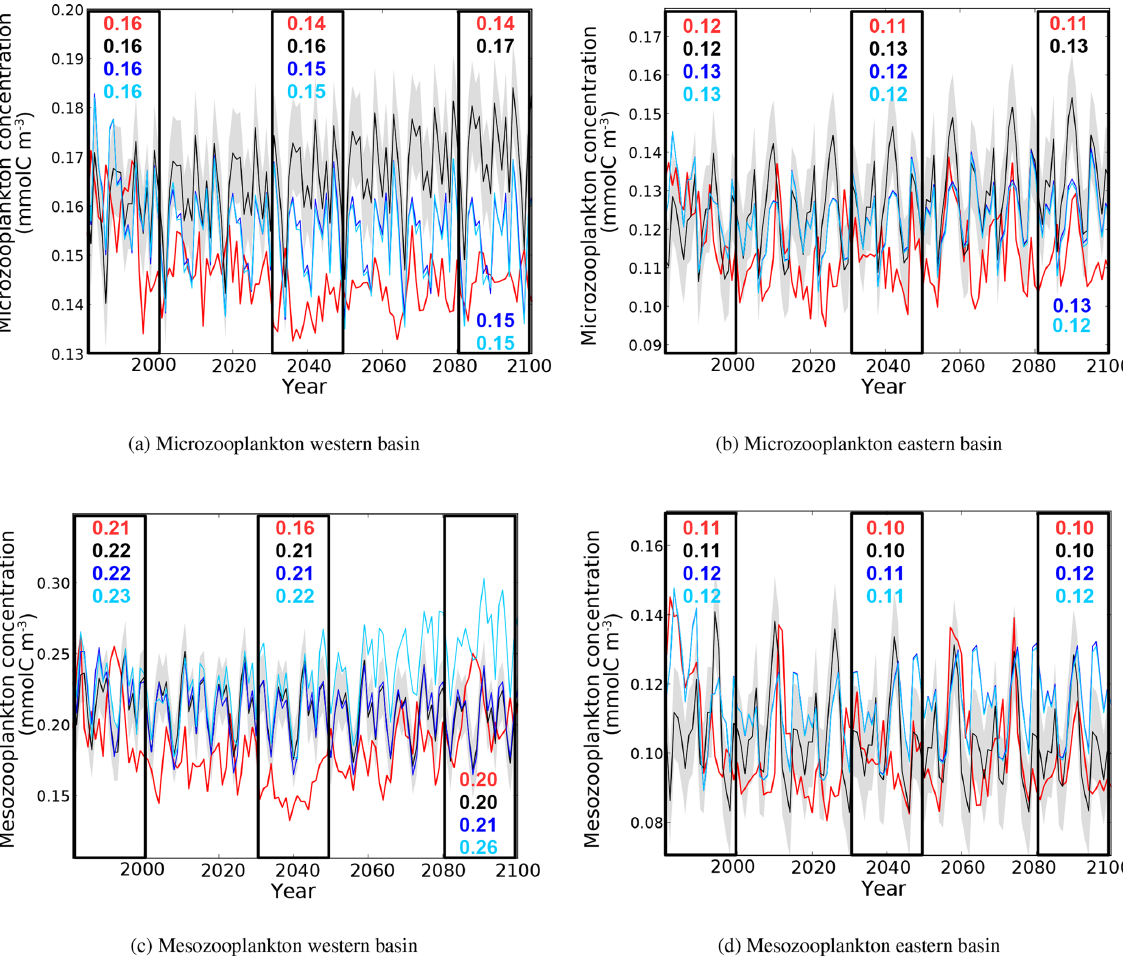
Figure 16. Evolution of yearly average microzooplankton and mesozooplankton concentrations (10 − 3 molm − 3 ) in the surface layer of the western and eastern basins. Red lines represent the HIS/A2 simulation, black lines represent the CTRL simulation (with standard deviation), and blue and light blue lines represent the CTRL_R and CTRL_RG simulations respectively. Colored numbers in the highlighted areas represent the average concentrations in the corresponding simulations for the corresponding time